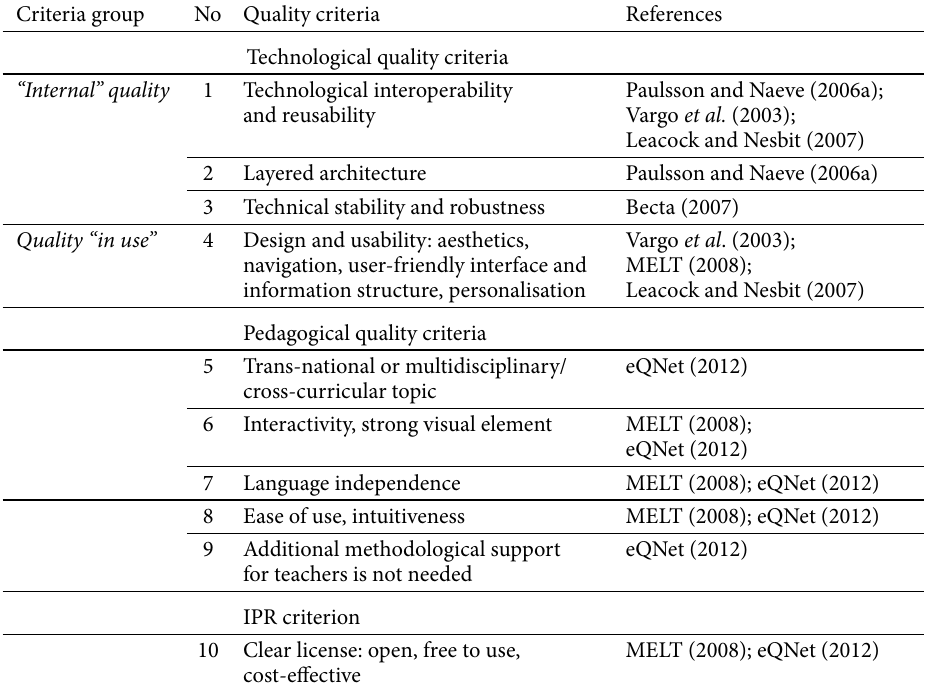
Table 3. Learning objects quality model (criteria system) Criteria